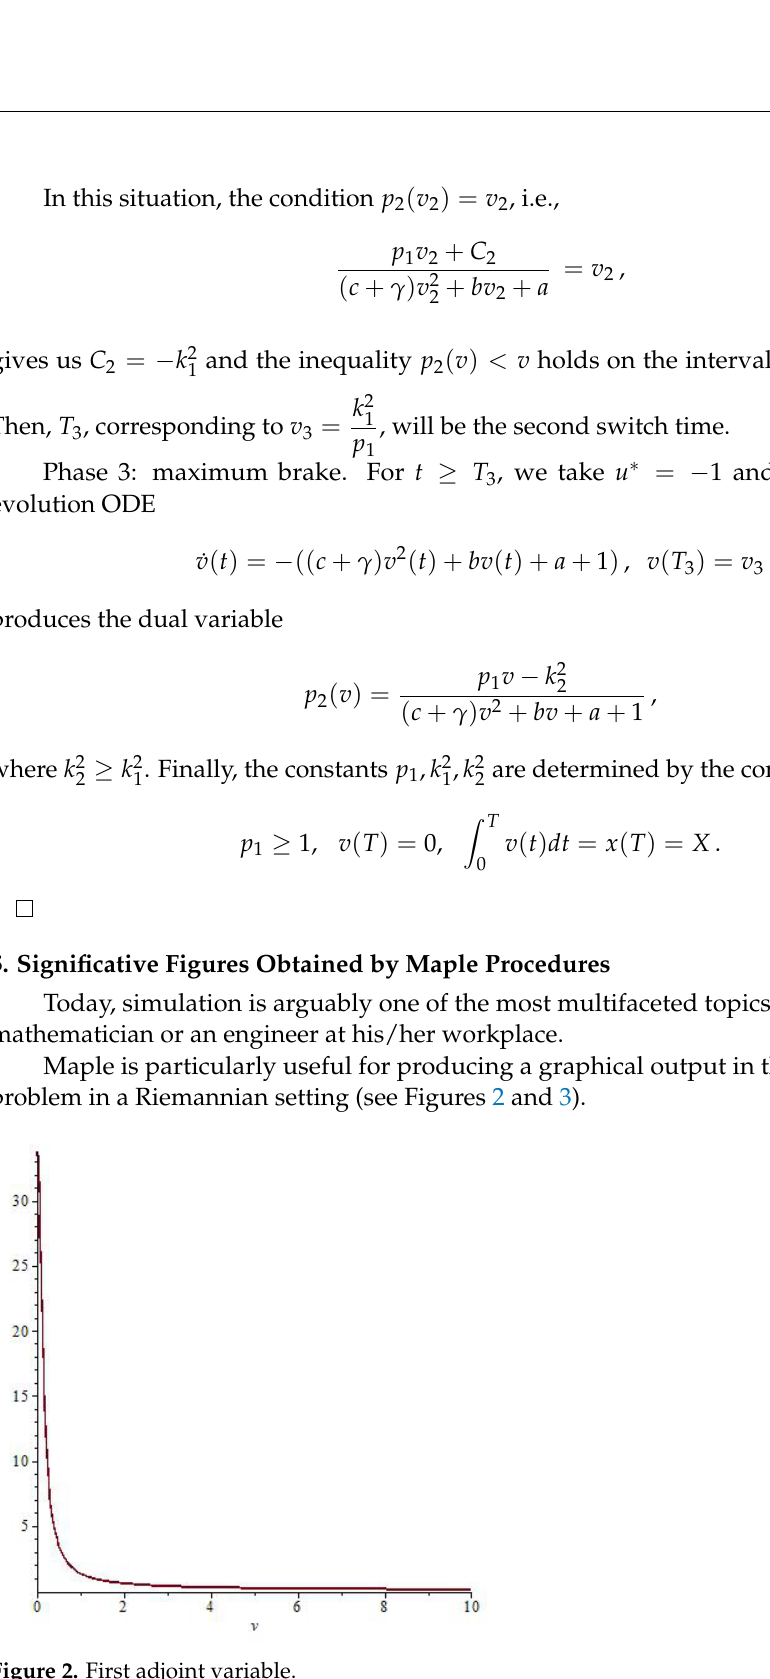
Figure 2. First adjoint